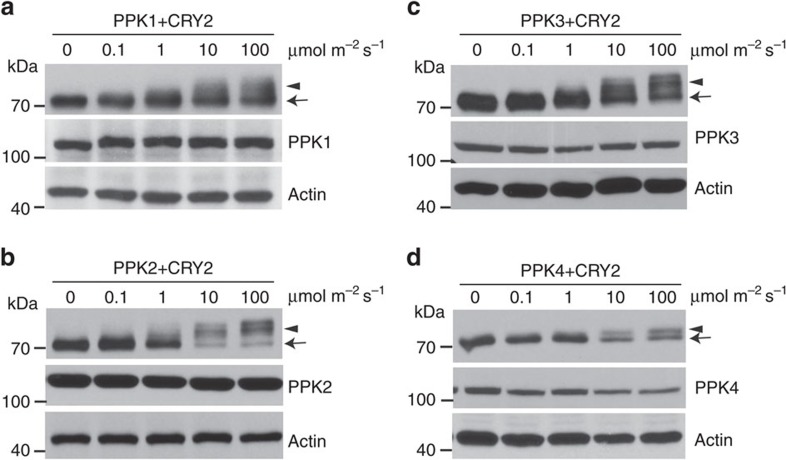
The fluence-rate response of the light-dependent phosphorylation of CRY2 catalysed by PPKs.Immunoblot assays showing the fluence-rate response of the blue light-dependent phosphorylation of CRY2 catalysed by PPK1 (a), PPK2 (b), PPK3 (c) and PPK4 (d) in HEK293T cells. Cells co-transfected to express CMV::Myc-CRY2 and indicated individual CMV::Flag-GFP-PPKs were exposed to the different fluence rates of blue light (0–100 μmol m−2 s−1) for 30 min. CRY2 and PPK were detected by immunoblots probed with anti-Myc or anti-Flag antibodies, respectively. Arrowheads and arrows indicate phosphorylated CRY2 (upshift bands) and unphosphorylated CRY2, respectively.